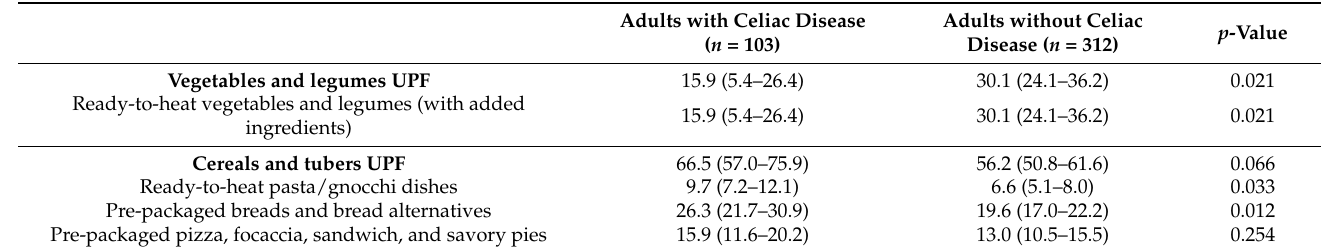
Table 2. UPF intake (g/day) in adults according to the presence of celiac disease. Adults with Celiac Disease Adults without Celiac ( n = 103) Disease ( n =